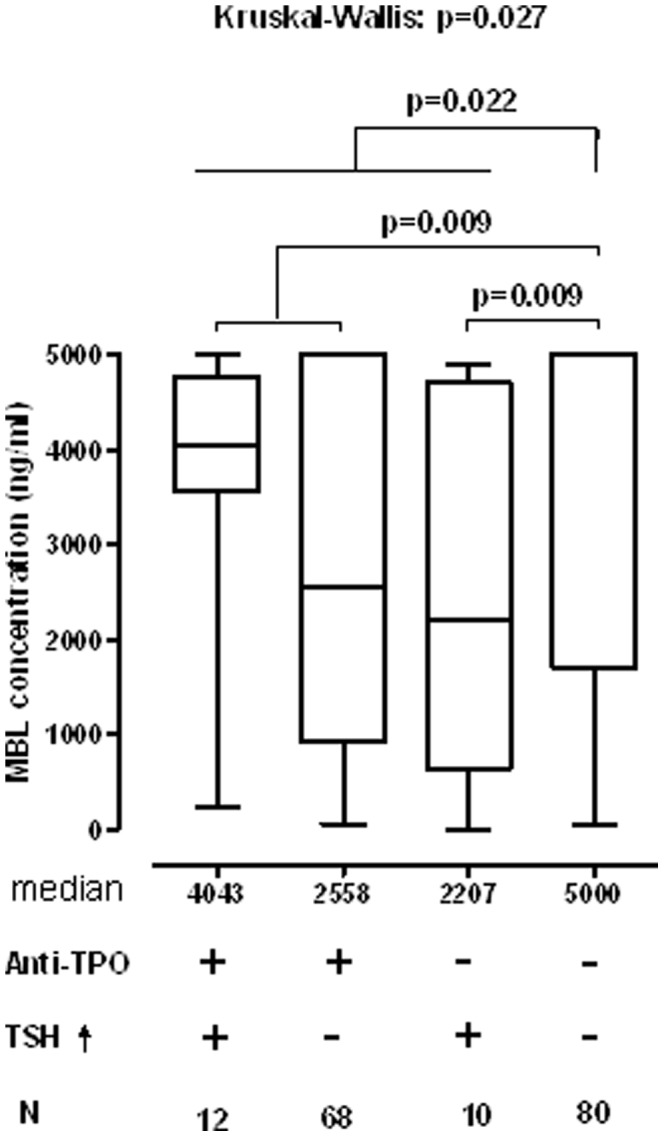
Serum MBL levels in pregnant women according to positivity for TPOAb and the presence of hypothyroidism.The box plots show median, interquartil range and total ranges.